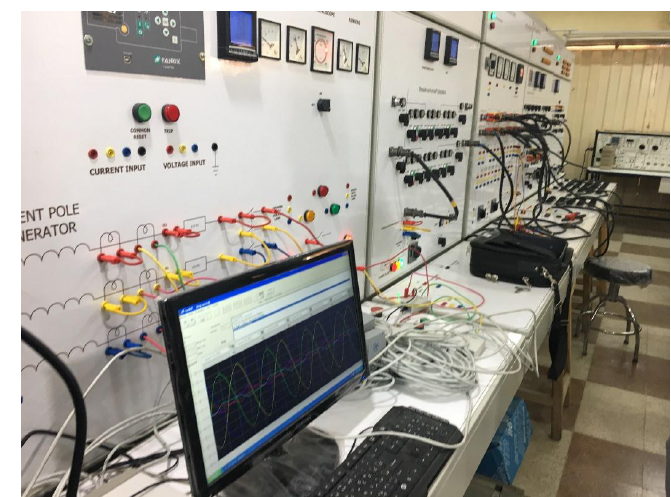
Figure 16. Actual test on power system simulator in Central Power System Laboratory in Persian Gulf University.